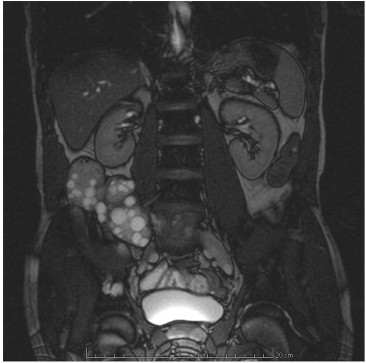
Figure 8. Demonstration of a retroperitoneal multilocular hypointense cystic lesion extending from the right ileopsoas muscle to the subhepatic area on coronal T2-weighted abdominal magnetic resonance image.